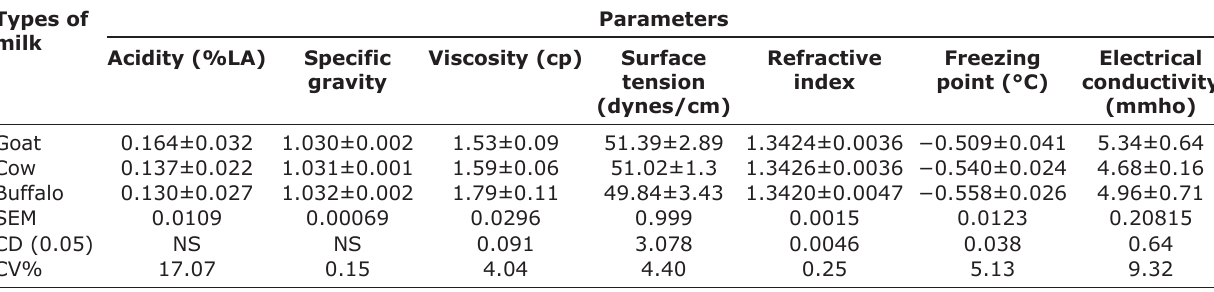
Table-1: Physicochemical characteristics of goat, cow and buffalo milk. Types of